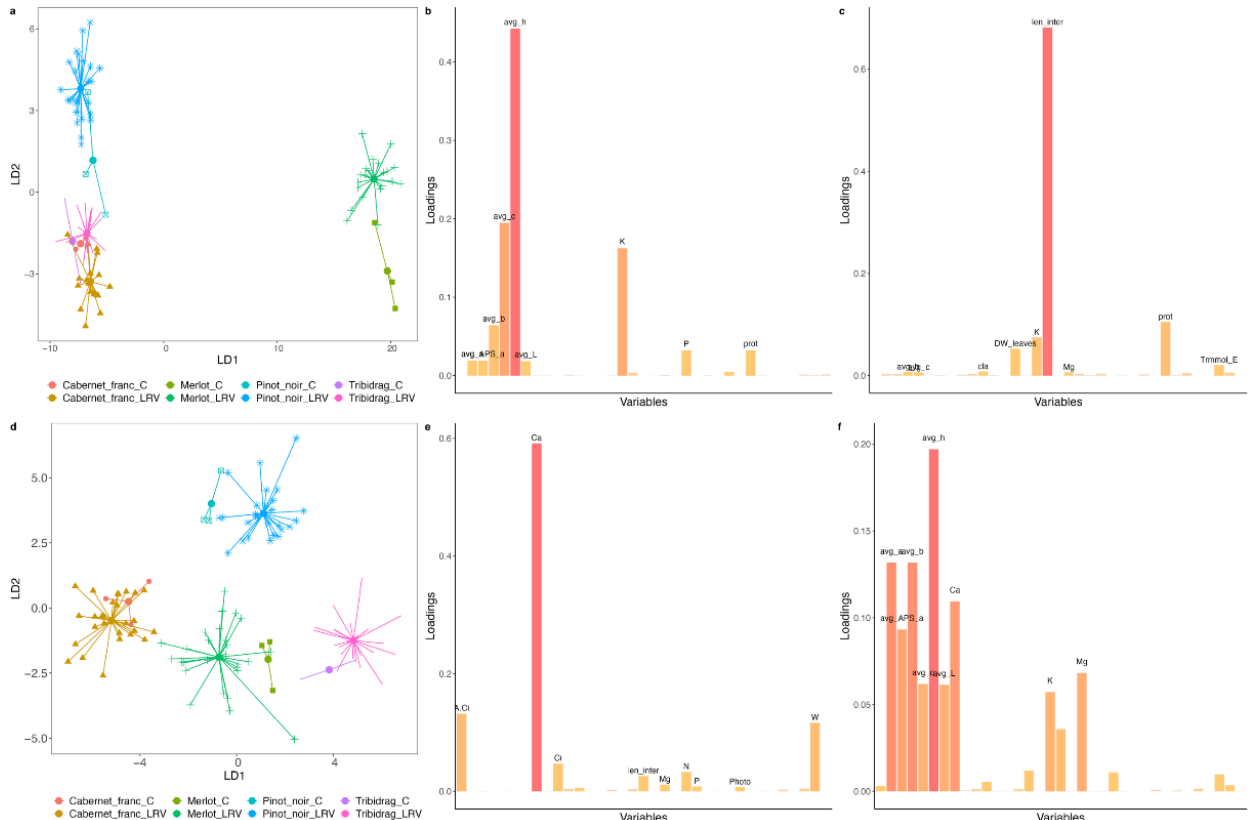
Figure 1. Plots generated by Discriminant Analysis of Principal Components (DAPC) from data collected for leafroll (LR) isolates in the first year of measurement in 2020 ( a – c ) and in 2021 ( d – f ). ( b , e ) represent variables that were important for the first discriminant function (LD1); ( c , f ) represent variables that were important for the second discriminant function (LD2). Abbreviations are listed in Table S1.